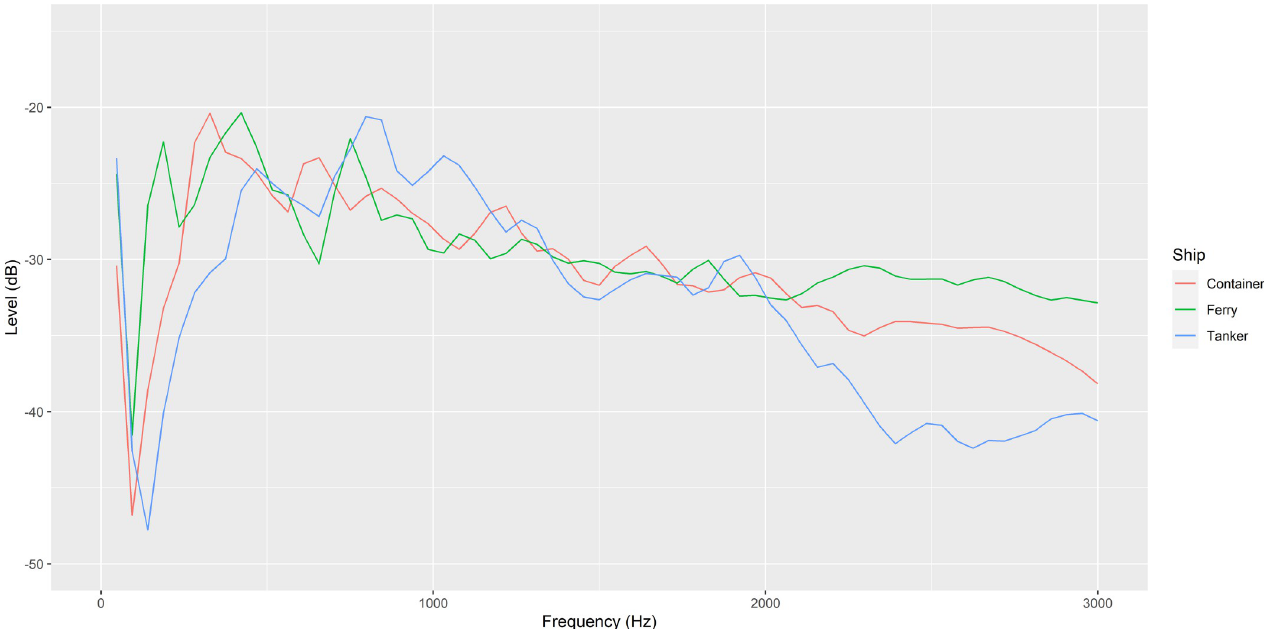
Fig 3. Spectrograph (Hann window, size 1024) showing the average sound profile (amplitude/level and frequency) of the original recording of three ships recorded in UK harbours approximately 200 metres away [17].